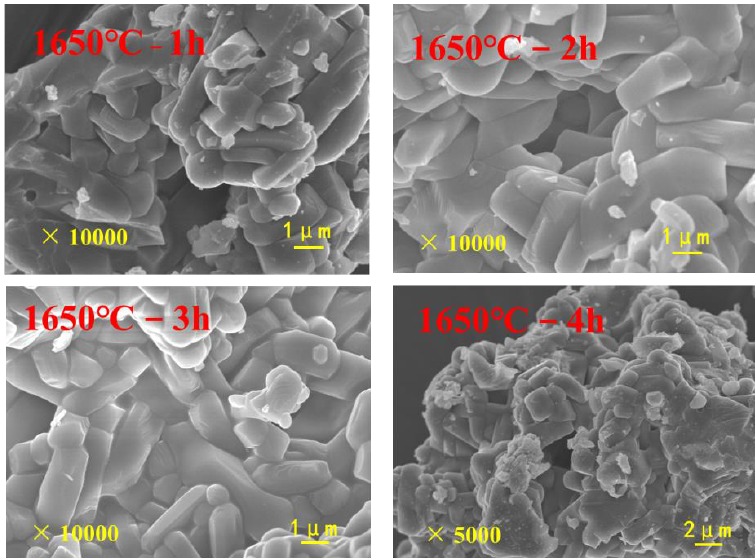
Figure 10. Effects of calcination time on mullite properties.